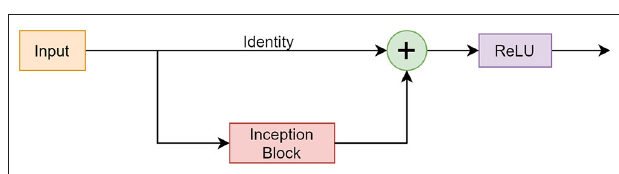
FIGURE 4 | (A) standard skip connection is shown. (B) implementation of skip connection with Inception module.